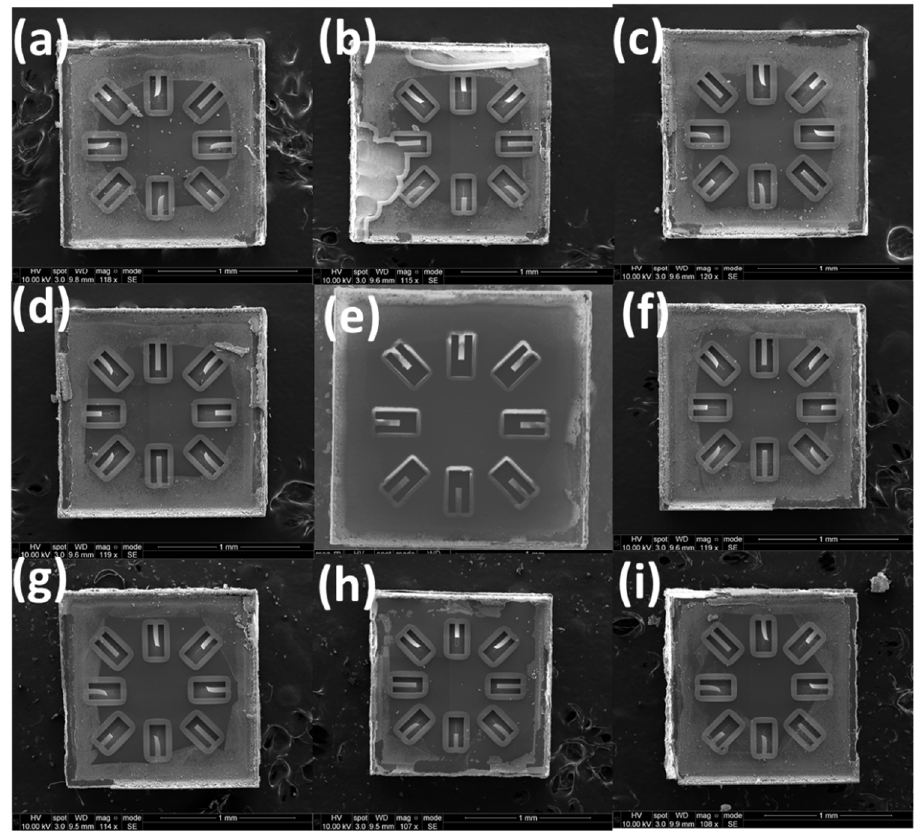
Figure 4. ( a – i ) SEM images of cantilevers formed from 500 nm thick PVD Al 0.68 Sc 0.32 N films deposited under a constant N 2 flow of 25 sccm. Each die was pulled from the north (N), northeast (NE), east (E), southeast (SE), south (S), southwest (SW), west (W), and northwest (NW) locations of the wafer shown in Figure 3b.